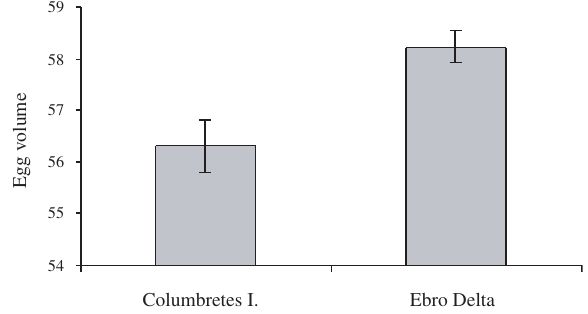
F IG . 3. – Mean (± SE) egg volume (cm 3 ) of Audouin’s gull ( Larus audouinii ) eggs from the Columbretes Islands and the Ebro Delta. Volume was calculated by the equation: egg volume (cm 3 ) = 0.000467 x length (mm) x width 2 (mm), after Hoyt